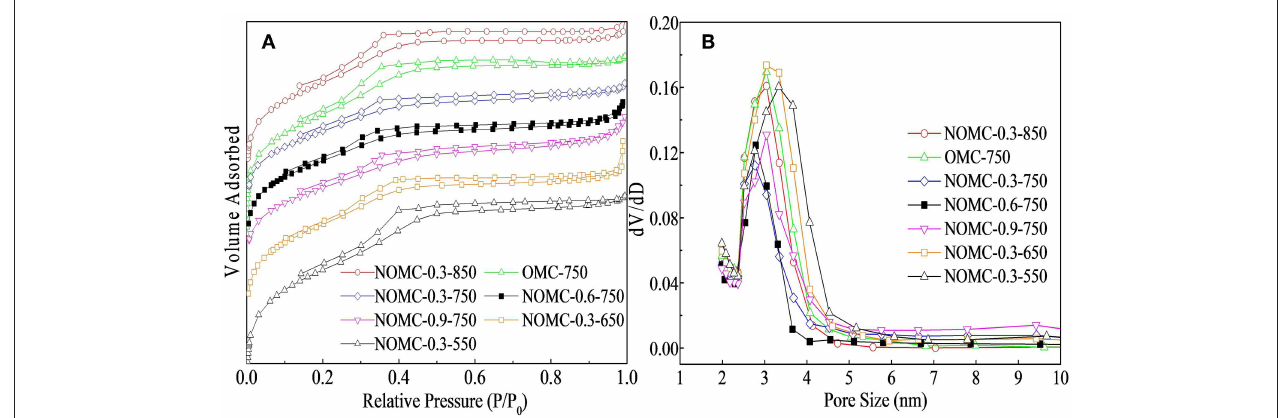
FIGURE 1 | N 2 sorption isotherms (A) and pore–size distribution plots (B) of OMC and NOMCs.